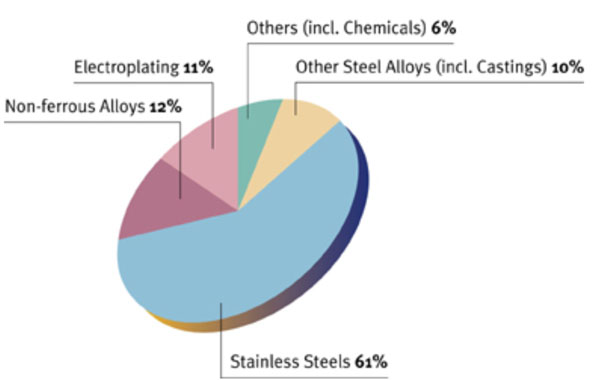
Nickel First Use [5]